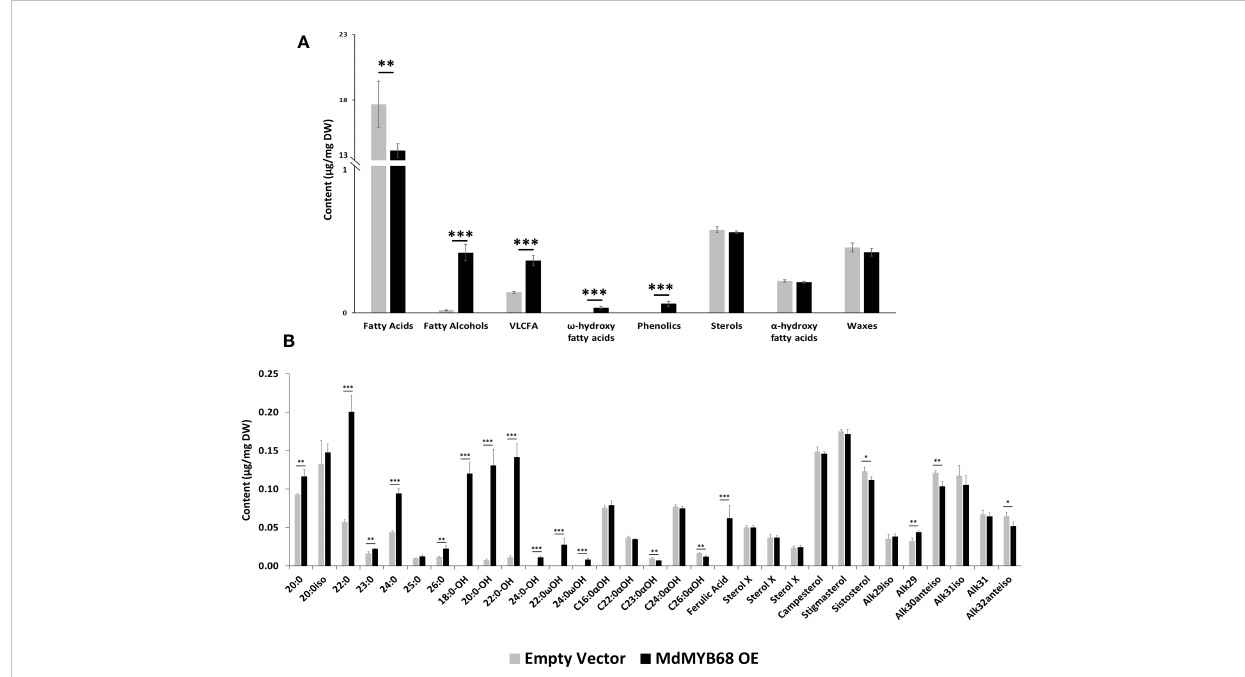
FIGURE 5 GC-MS analysis performed from the soluble lipid fraction obtained from Nicotiana benthamiana leaves collected 7 days after agroin fi ltration with the MdMYB68 construct (MdMYB68 OE) or the Control/empty vector construct (Empty vector). 4 biological replicates were used (n=4). (A) content gathered by lipid subclasses, (B) fatty acids, fatty alcohols, w - and a -hydroxy fatty acids, ferulic acid, sterols, and waxes. C16 to C18 fatty acid contents are displayed in the Supplementary Figure 3. Values are expressed as the mean ± SD from four biological replicates. One, two and three asterisks indicate signi fi cant differences at p < 0.05, p < 0.01, p < 0.001,